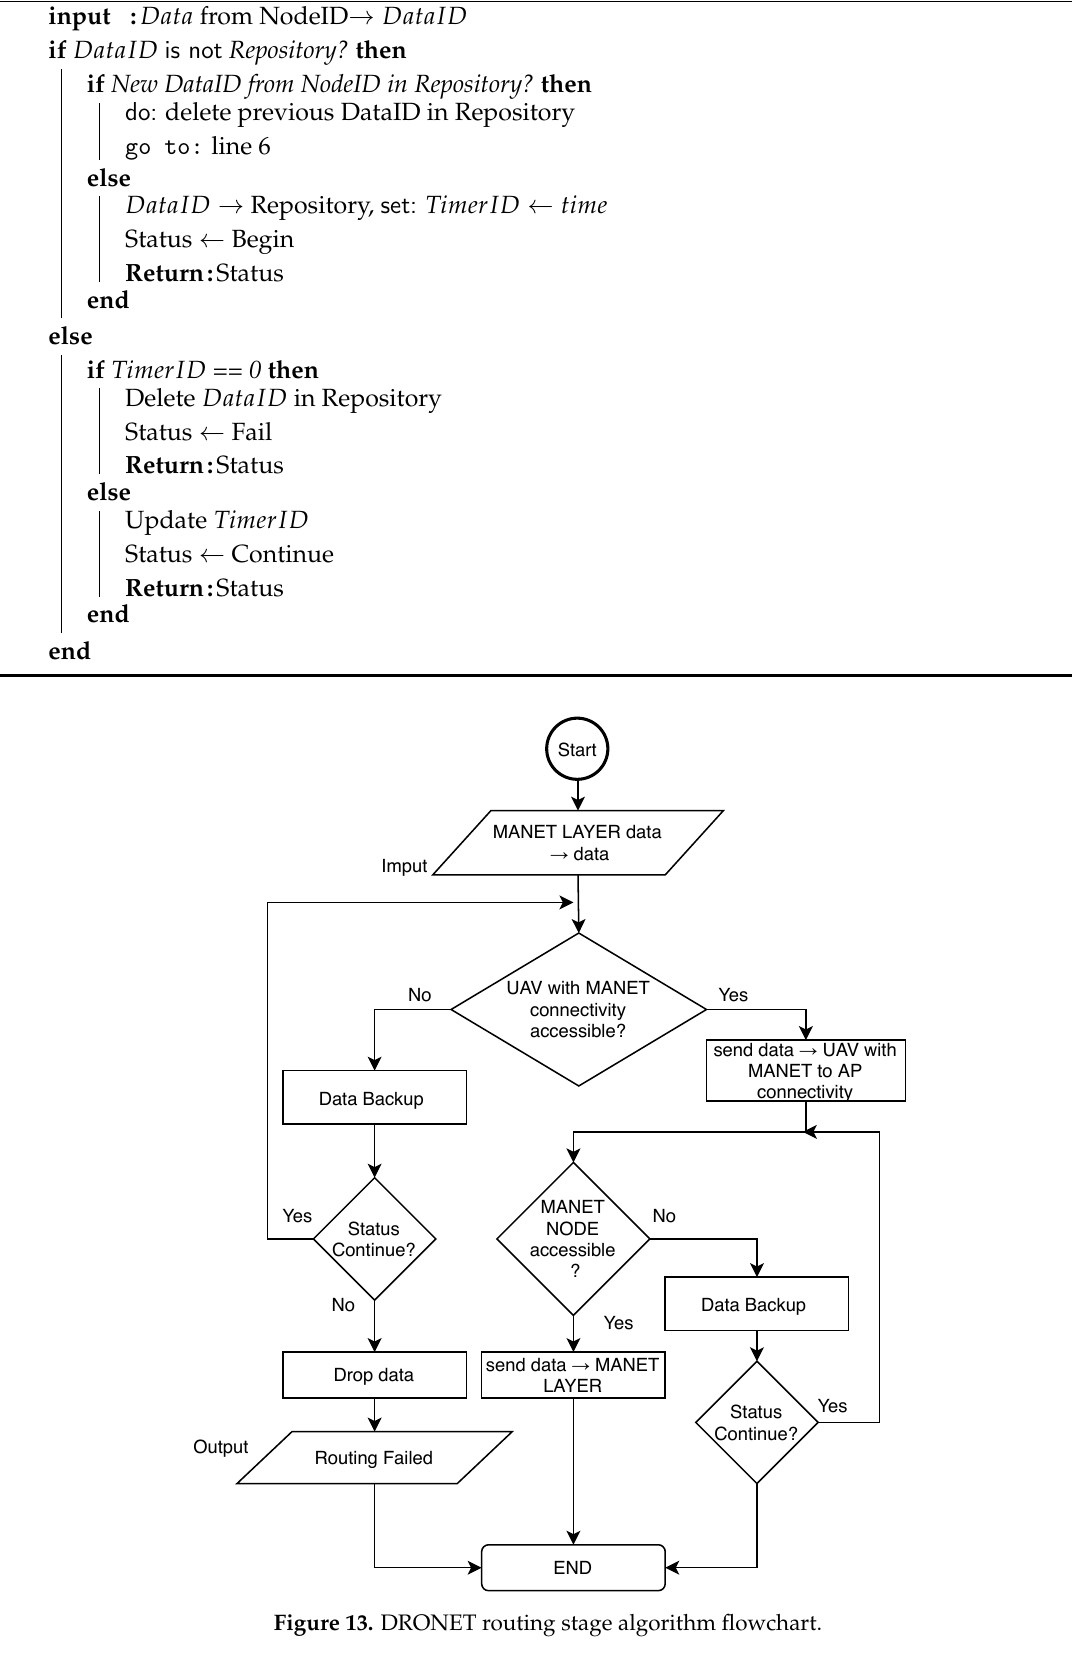
Algorithm 2: Data Backup algorithm for DRONET layer